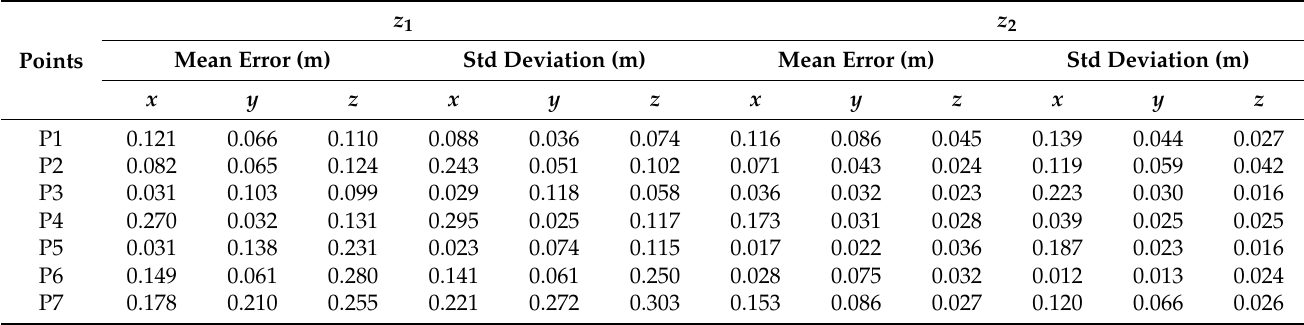
Table 5. Mean positioning errors and standard deviations for points P1–P7 at z 1 = 1.35 m and z 2 = 1.93 m after an AKF